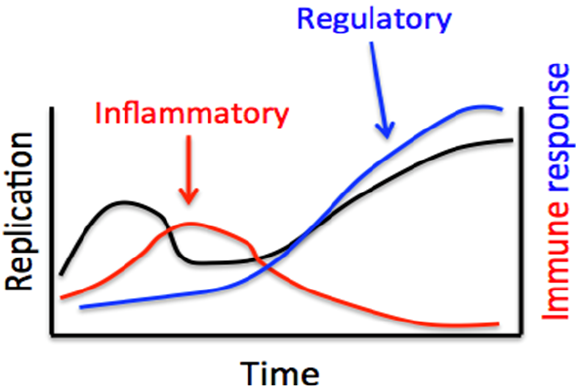
Figure 1. Model of the immune response of deer mice infected with Sin Nombre virus (SNV). During acute infection, SNV elicits a modest inflammatory response that initially limits, but does not clear, virus. Within a few weeks, the response transitions to a regulatory response that may allow episodic recrudescence of virus that can be